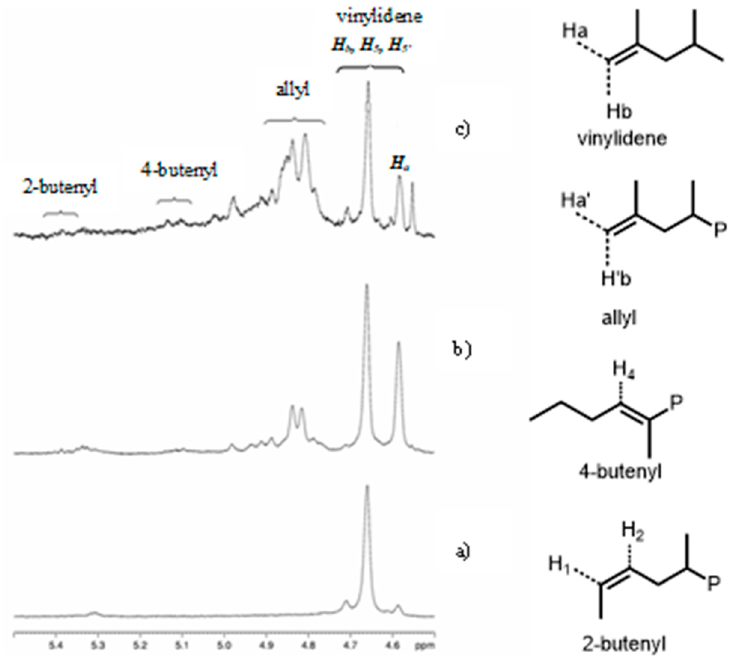
Figure 9. Olefinic region expansion of 1 H-NMR spectra (108.58 MHz, C 2 D 2 Cl 4 , 103 °C) of PP samples